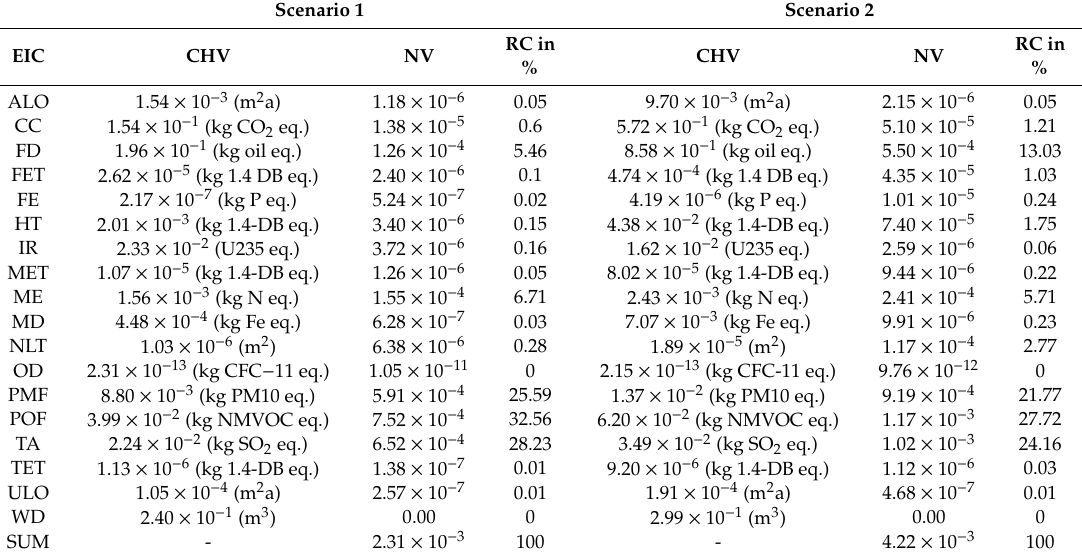
Table 8. Results for both scenarios (EIC—environmental impact categories, CHV—characterization values, NV—normalization values, RC—relative contribution); ozone depletion (OD), human toxicity (HT), ionizing radiation (IR), photochemical oxidant formation (POF), particulate matter formation (PMF), terrestrial acidification (TA), climate change (CC), terrestrial ecotoxicity (TET), agricultural land occupation (ALO), urban land occupation (ULO), natural land transformation (NLT), marine ecotoxicity (MET), marine eutrophication (ME), fresh water eutrophication (FE), fresh water ecotoxicity (FET), fossil depletion (FD), metal depletion (MD), water depletion